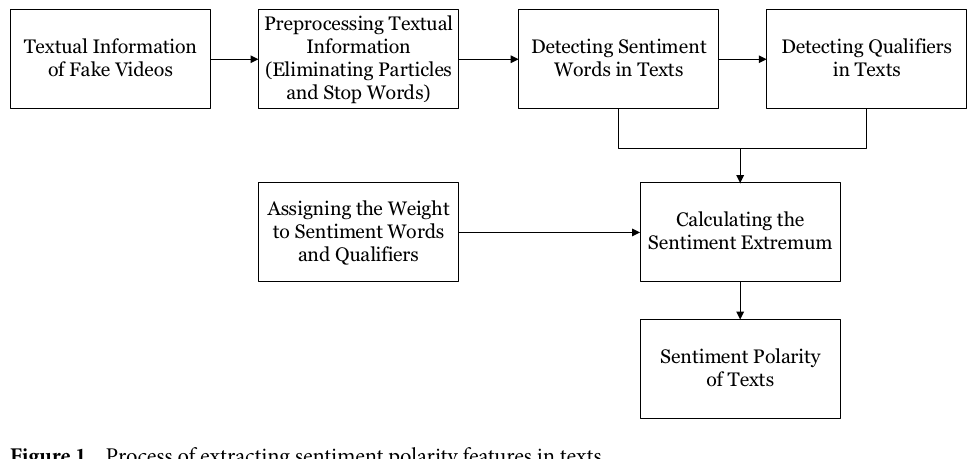
Figure 1. Process of extracting sentiment polarity features in